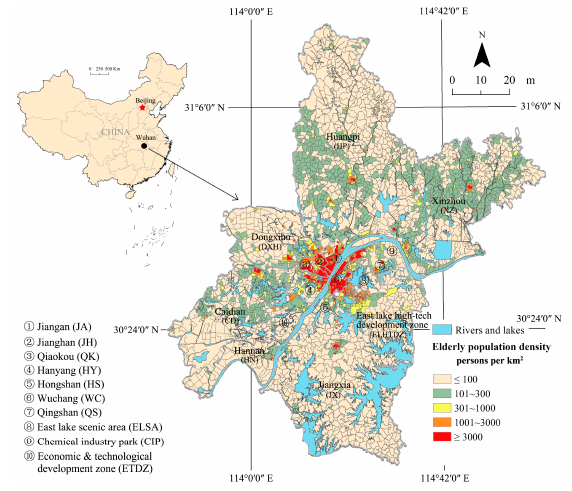
Figure 1. The elderly population density of Wuhan city in 2016.